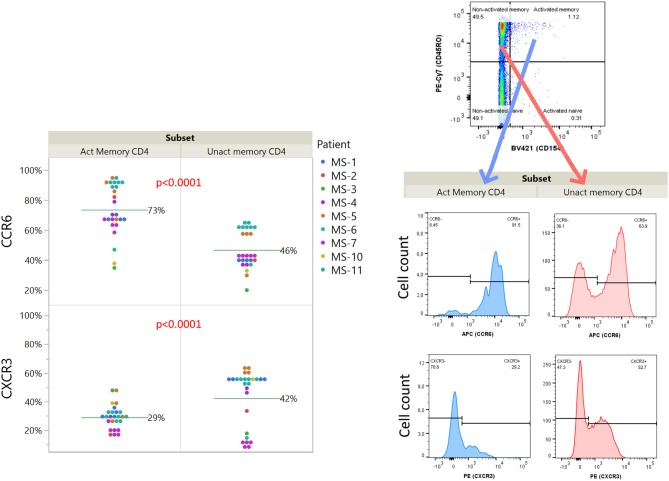
Relative expression of chemokine receptors CCR6 and CXCR3 on idiotope specific CD4+ T cells. Expression among activated (CD154+) or un-activated (CD154−) memory (CD45RO+) CD4+ T cells responding toward predicted idiotope peptides. P-values are results of full factorial mixed model, differences shown are un-adjusted values. An example of gating for analysis (MS-11, sample 15) is shown for illustration.